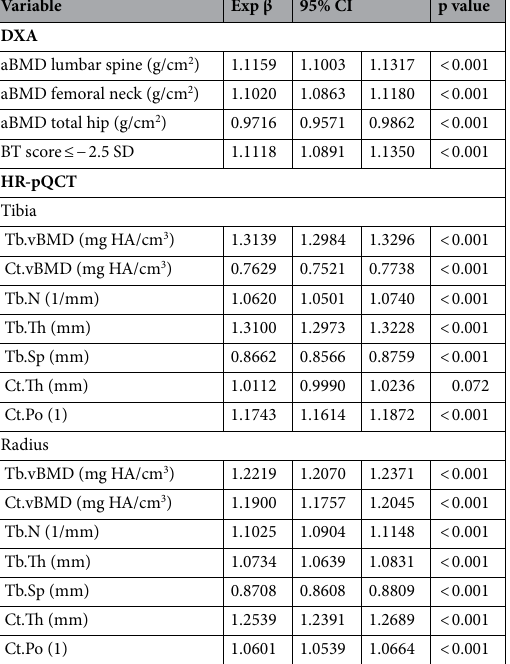
Table 4. Bone mineral density (DXA) and bone microarchitecture (HR-pQCT) for CAC status ( z score) in women. Exp β equation coefficient, aBMD areal bone mineral density, BT score bone T -score, SD standard deviation, Tb.vBMD trabecular volumetric density, Ct.vBMD cortical volumetric density, Tb.N trabeculae number, 1 mm, Tb.Th trabecular thickness, Tb.Sp separation between trabeculae, Ct.Th cortical thickness, CT. Po cortical porosity, CI confidence